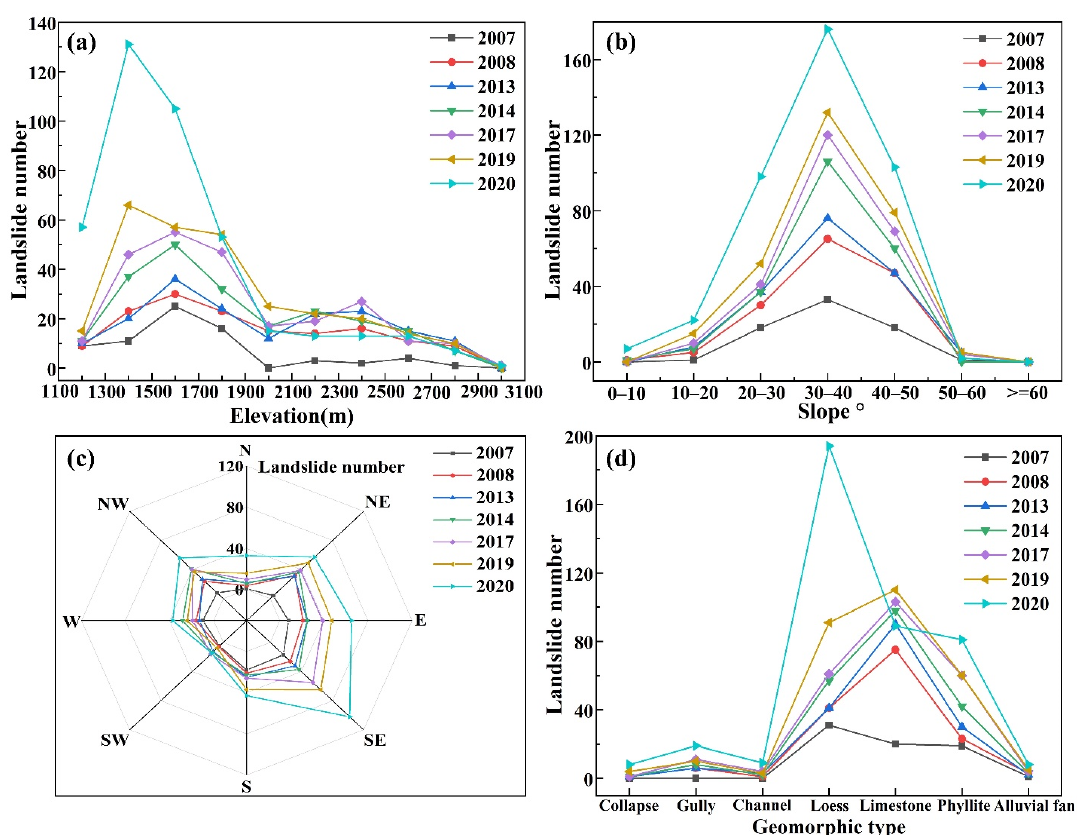
Figure 10. Various characteristics of landslide distribution. ( a ) Elevation distribution of landslides; ( b ) slope distribution of landslides; ( c ) aspect distribution of landslides; ( d ) geomorphic distribution of